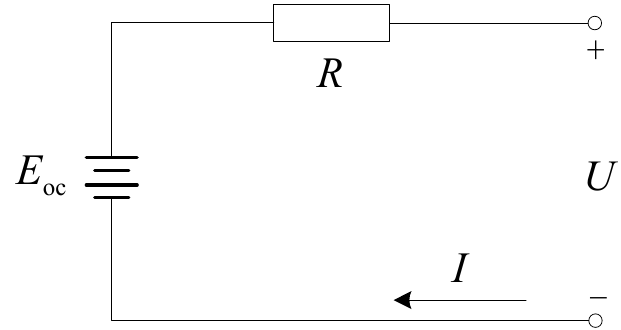
Figure 4. Schematic of Rint battery model.